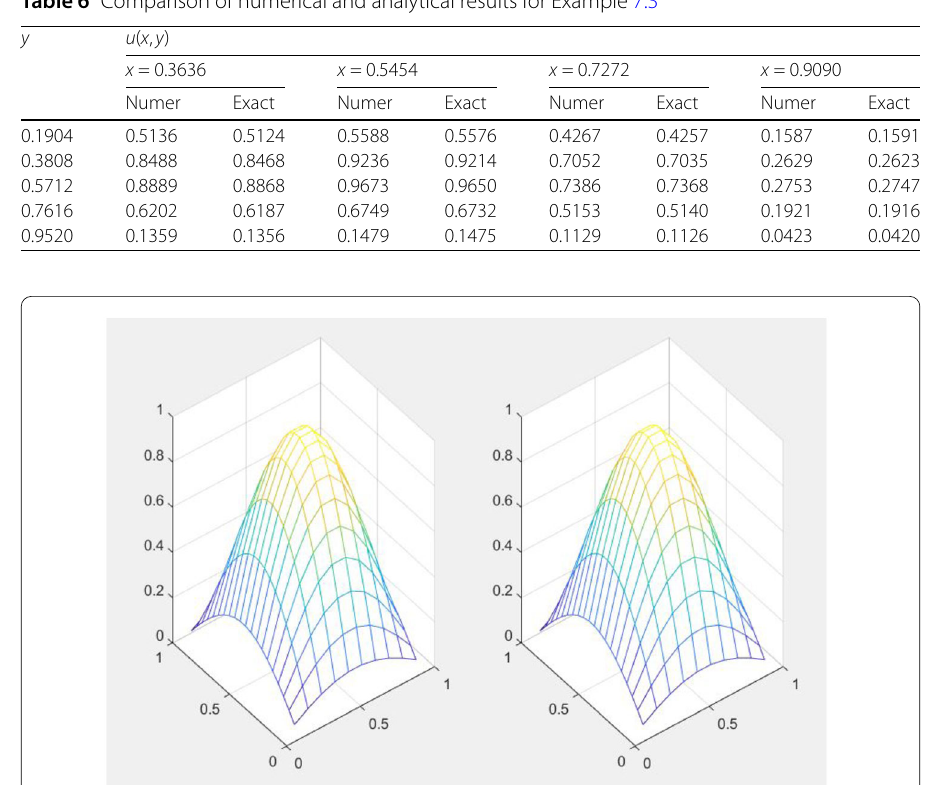
Figure 6 The 3D-plot of the analytical solution (left) and the numerical solution (right) for Example 7.3